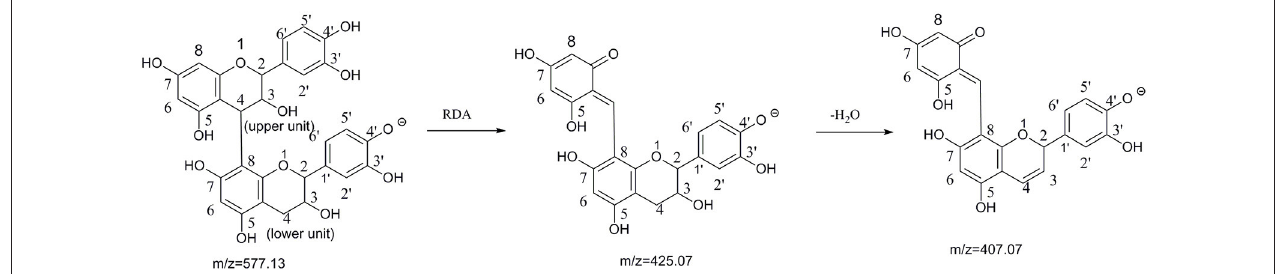
FIGURE 1 | The pathway of retro-Diels-Alder(RDA) cleavage of procyanidin B2 and binding site label (Sun and Miller, 2003; Stoupi et al.,